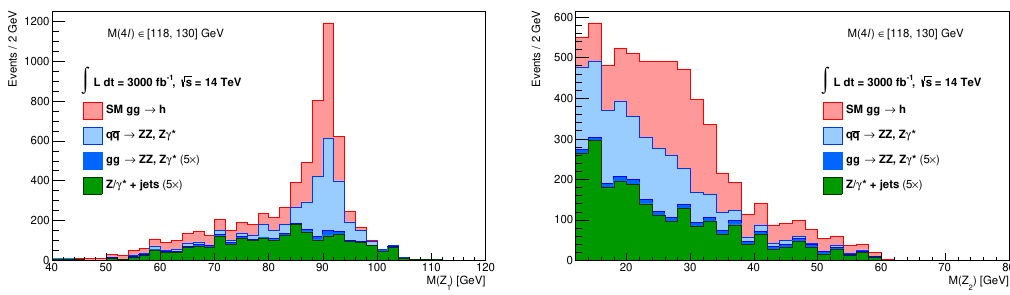
Figure 3 . Invariant mass distribution M ( Z i ) of the (left) Z 1 and (right) Z 2 candidates after defining the signal region M (4 ‘ ) ∈ [118 , 130] GeV. Stacked histograms follow the same color coding and normalisation as figure 2. The gluon-initiated and Z/γ ∗ + jets background distributions are scaled ( 5 × ) for visualisation